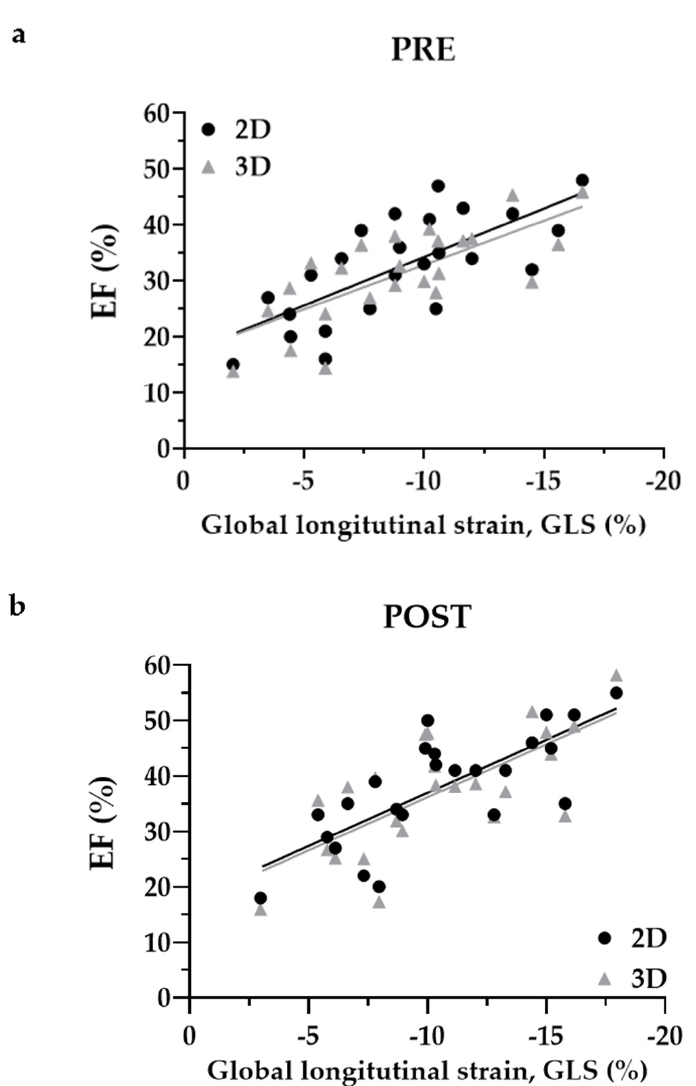
Figure 3. Scatter plots comparing GLS with EF. GLS correlates with 2D and 3D left ventricular EF in a model of simple linear regression before (( a ), pre) and after (( b ), post) ECV. The slopes deviate significantly from zero and do not differ significantly among each other. GLS, global longitudinal strain; EF, ejection fraction; ECV, electrical cardioversion.